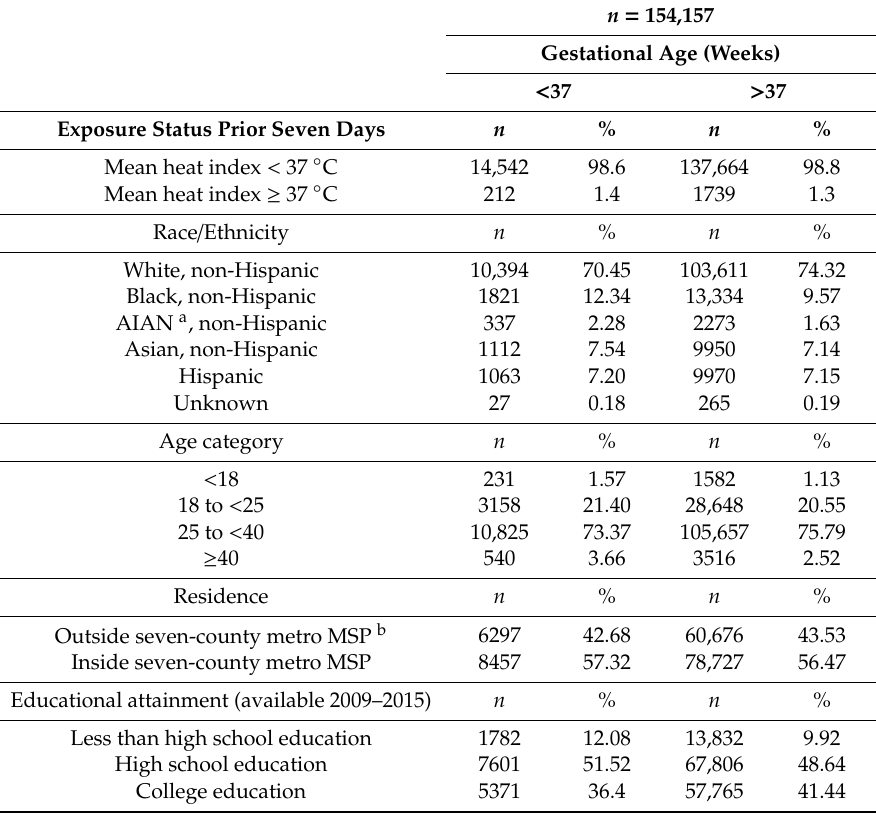
Table 1. Descriptive characteristics of mothers of preterm ( < 37 weeks) and full-term ( ≥ 37 weeks) births, for all live births in Minnesota from 2009 to 2015, and births to women 25 and up from 2009 to 2015. n =